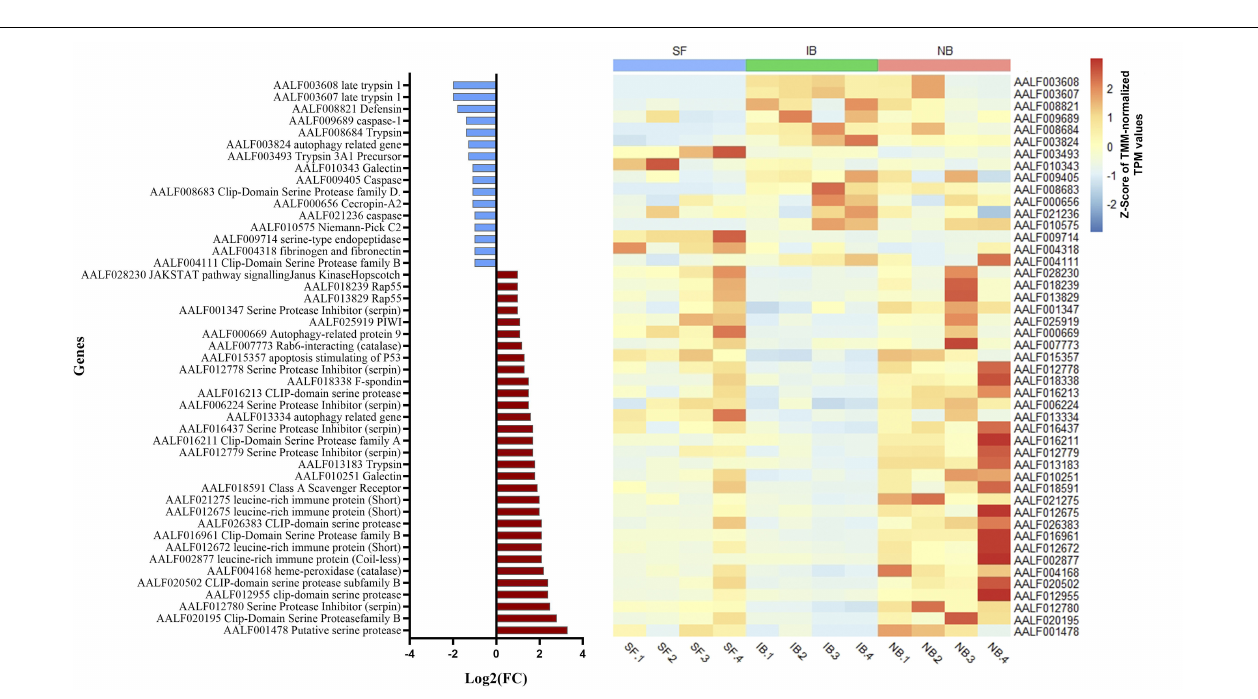
FIGURE 3 | Differentially expressed genes influenced by the presence of active complement. (A) Volcano plot for the differentially expressed genes (DEGs), Normal Blood vs. Inactivated Blood. Upregulated (red plots) and downregulated (blue plots) DEGs. (B) KEGG pathways enrichment identified in DEGs between NB vs. IB. In red the upregulated pathways and in blue downregulated.